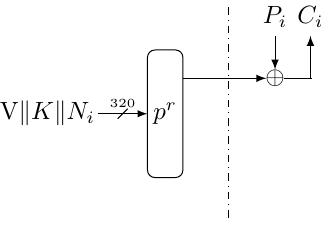
Figure 5: Our attack